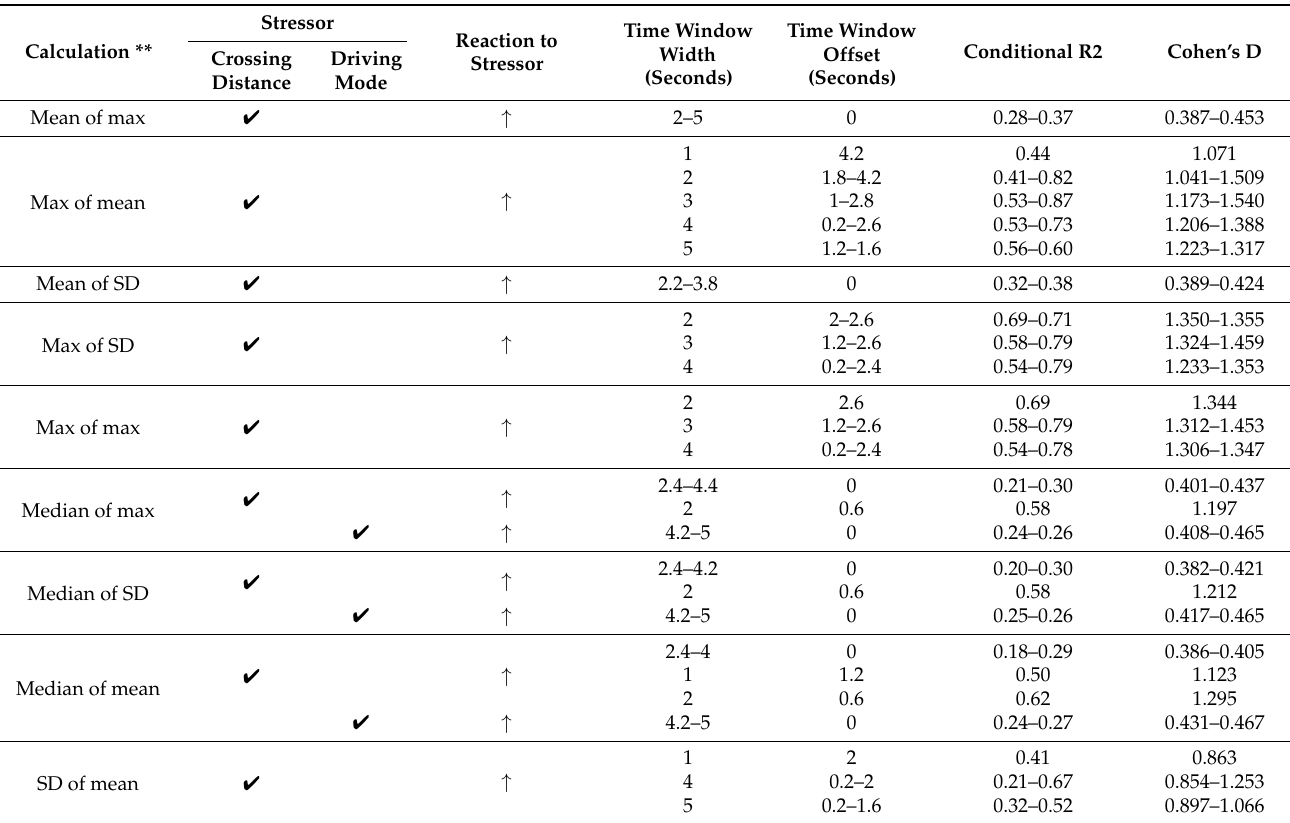
Table 1. Grip force calculations for all surfaces combined (60 sensors), as affected by one of